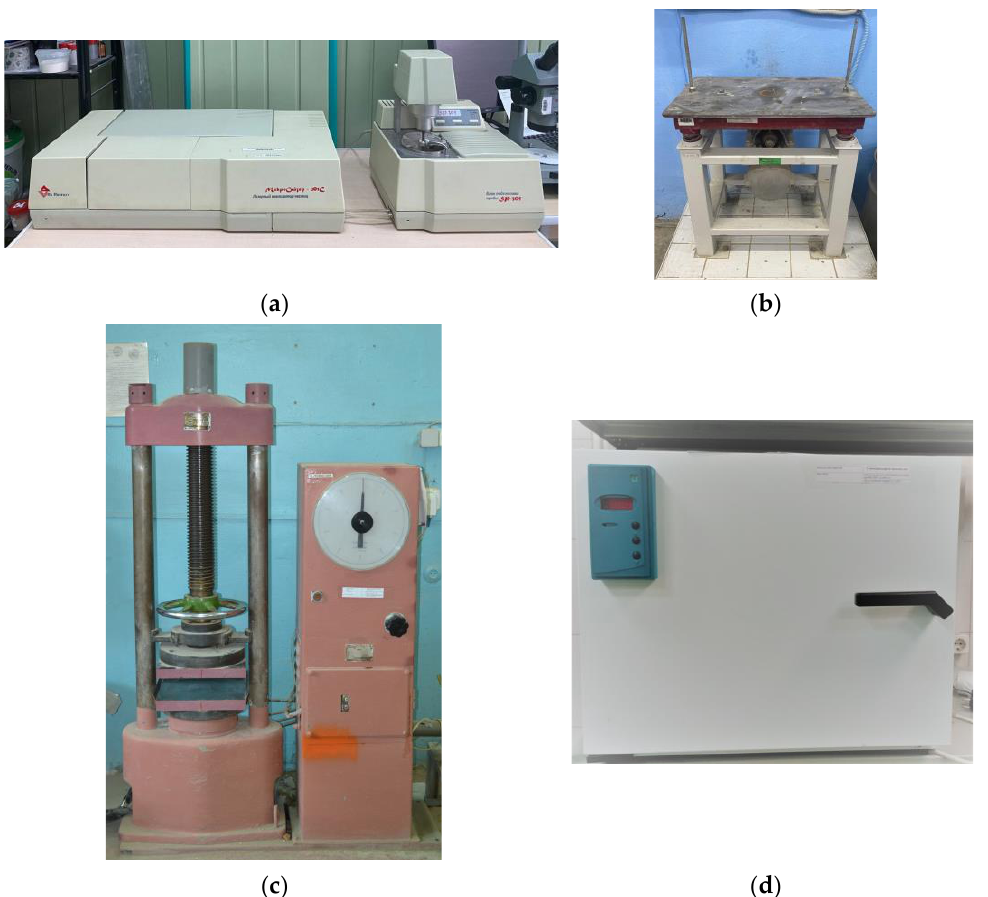
Figure 5. The main equipment used in the study: ( a ) Microsizer 201C for particle size analysis; ( b ) laboratory vibration platform for vibrating the mixture in the molds; ( c ) strength test press; ( d ) water absorption test oven.